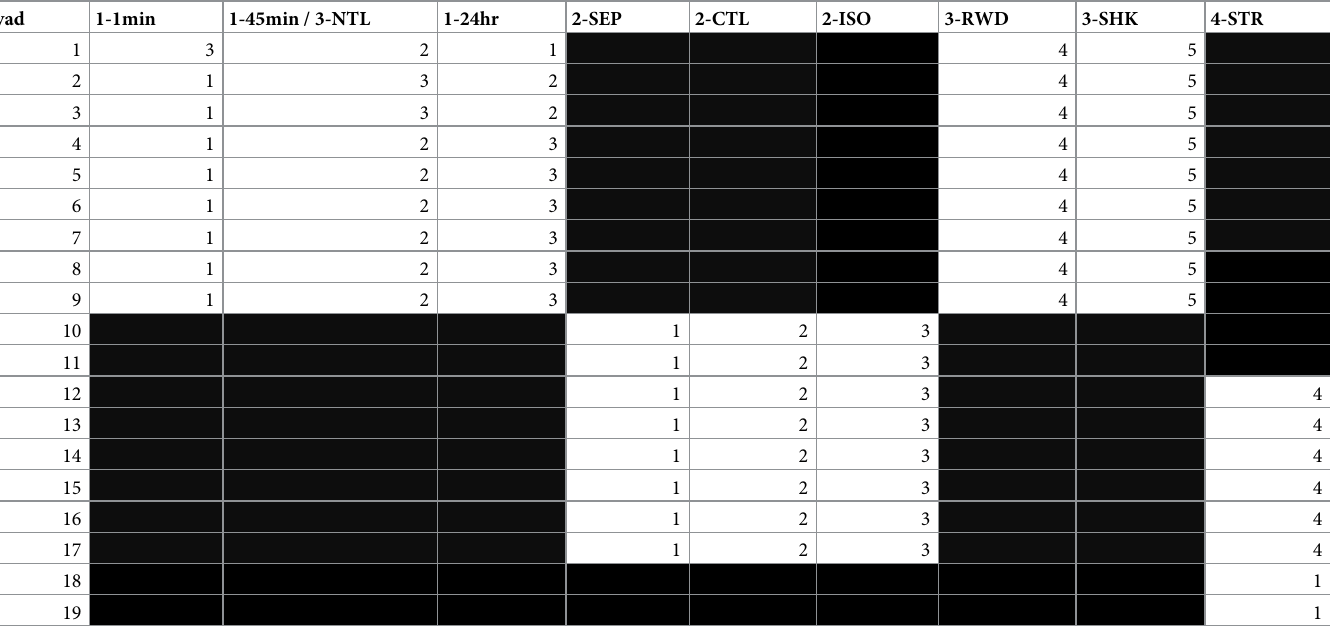
Table 1. Sequence of reunion exposures for each